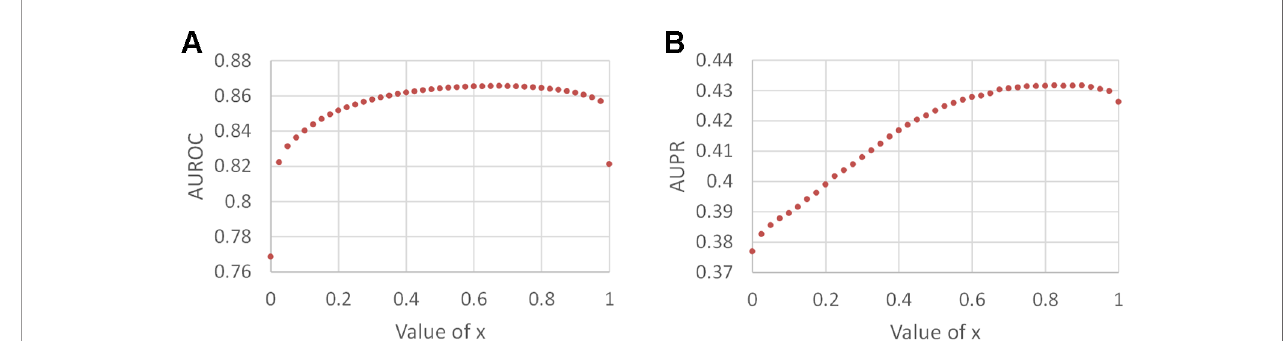
FIGURE 3 | Prediction performance of BNMP with network 2. (A) In fl uence on AUROC values by different balance parameter values. (B) In fl uence on AUPR values by different balance parameter values.